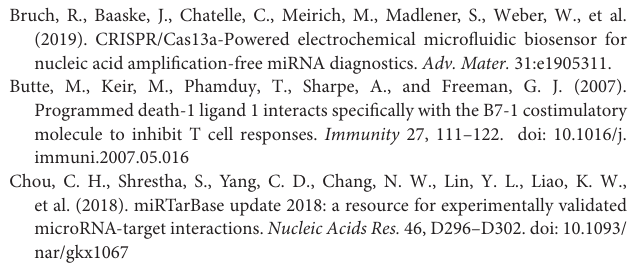
Supplementary Figure 1 | Gating strategy for the CD8 + T cell and PD-1-expressing CD8 + T cell. (A) Total lymphocytes were gated based on side-scatter and forward-scatter. (B) Doublets were eliminated from the analysis by FS-area (FS-A) and FS-height (FS-H). (C) Cells were further analyzed by expression of CD8. (D) Within CD8 + T cells and PD-1-expressing cells were